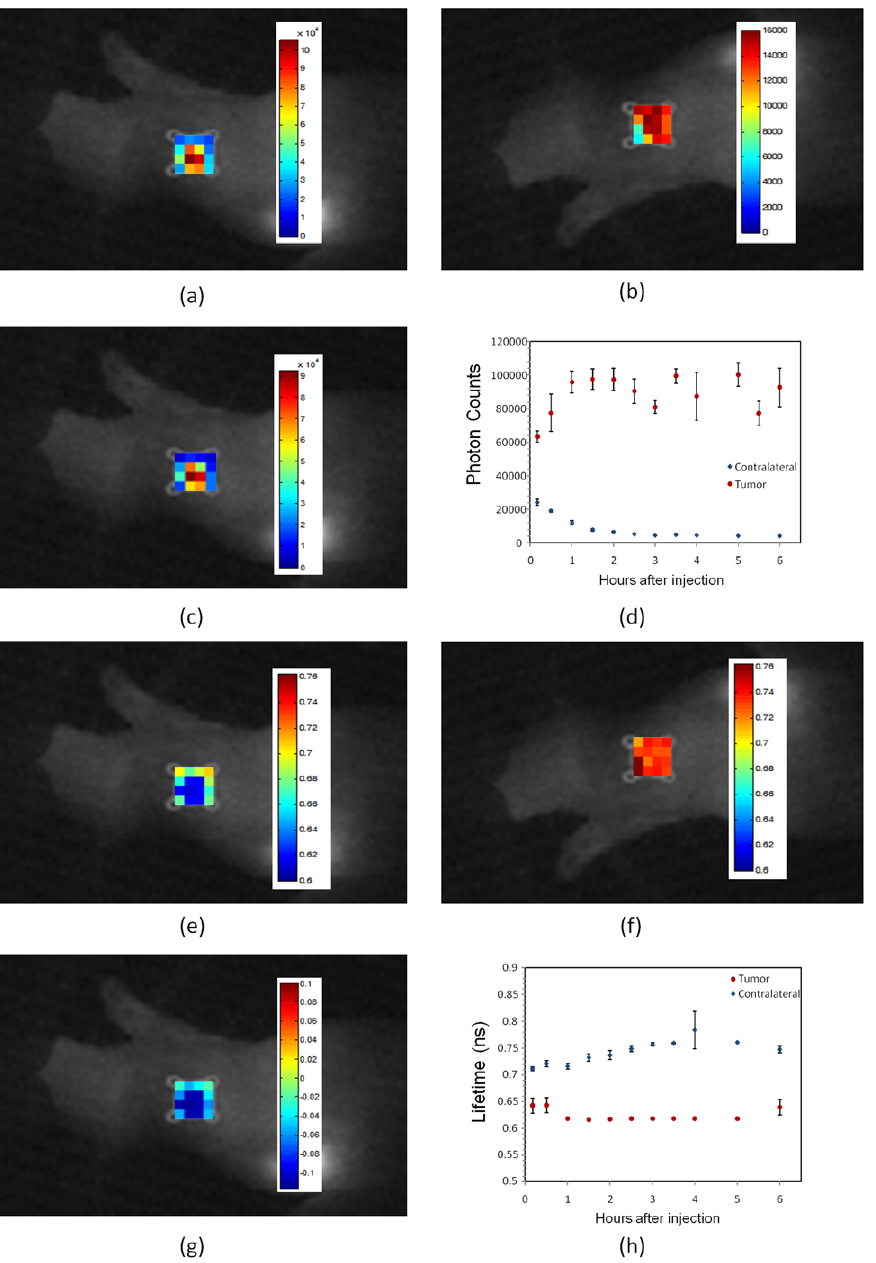
Figure 2. Invivo fluorescence imaging of xenograft mouse with high HER2 expressing human tumor model (BT-474) after injection of HER2-specific Affibody H (His6-Z HER2 :GS-Cys) conjugated to Dylight750. ( A ) Fluorescence intensity map at the tumor region. ( B ) Fluorescence intensity map at the contralateral site ( C ) The difference of fluorescence intensity at the tumor region and the contralateral site, mapped on the tumor region. ( D ) Pharmacokinetics of the fluorescence intensity at the tumor region and contralateral site after the injection over time. The fluorescent intensity was averaged over 16 pixels at the contralateral site. The data in Figs. ( D ) and ( H ) are the average data of four mice. Markers show the average and bars show the standard deviation. ( E ) Fluorescence lifetime map at the tumor region. ( F ) Fluorescence lifetime map at the contralateral site. ( G ) The difference of fluorescence lifetime at the tumor and the contralateral site mapped on the tumor region. ( E ) Pharmacokinetics of the fluorescent lifetime at the tumor region and contralateral site after injection over time. All lifetime and fluorescence intensity maps in figures 2,4–7 are from measurements at 1 hour after the injection of Affibody probe. In all measurements, the photons were counted over two seconds integration time, t 0 . To exclude saturation effect of the 16 bit camera, in the brightest pixels, where the corresponding limit of 65536 counts was reached before time t 0 , we have renormalized the data by multiplying photon counts, measured for lower integration time t , by factor t 0 /t. doi:10.1371/journal.pone.0031881.g002 Dylight750 in mice with NCI-N87 tumor xenografts is presented region and contralateral site before injection of the Affibody in Figs. 8C–8D for the tumor and the contralateral sites, probe. A comparison between the autofluorescence (before respectively. These measurements confirm that the autofluores- injection) and the fluorescence signal after injection of (A) HER2 cence level is very low relative to the probe fluorescence signal, specific Affibody-Dylight750 (B) HER2 non-specific Affibody-